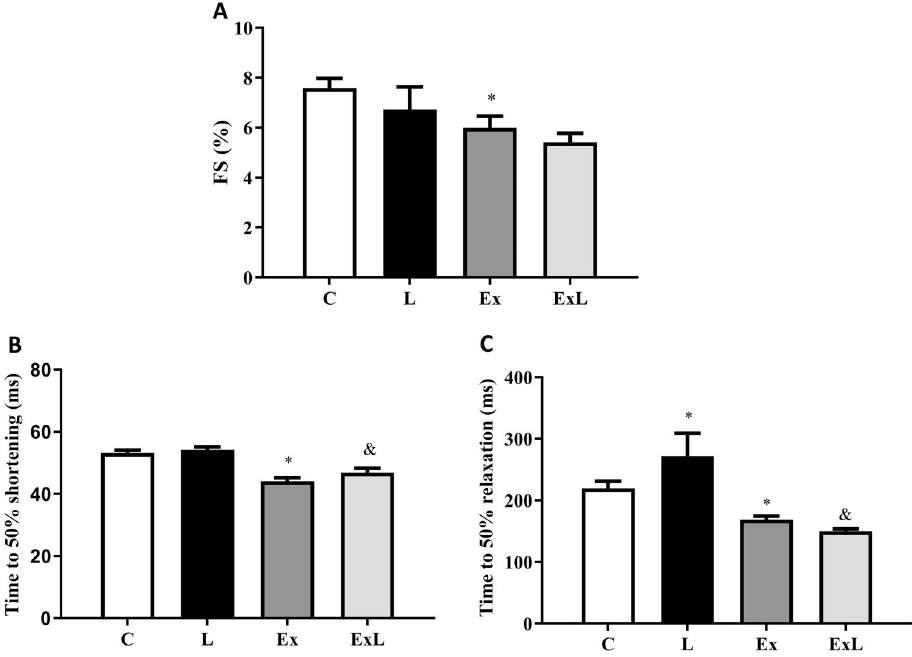
Figure 5. Contractile responses of cardiomyocytes from C: control (n=5; 42 cells); L: low-dose administration of L-NAME (n=4; 51 cells); Ex = chronic aerobic exercise (n=6; 111 cells); ExL: chronic aerobic exercise and low-dose administration of L-NAME (n=5; 94 cells). A , FS (%): fractional shortening: B , time to 50% shortening and C , relaxation. Data were obtained from electrical stimulation with 1 Hz and are reported as mean ± SEM. *P o 0.05 vs C; & P o 0.05 ExL vs L (two-way ANOVA followed by Tukey ’ s post hoc